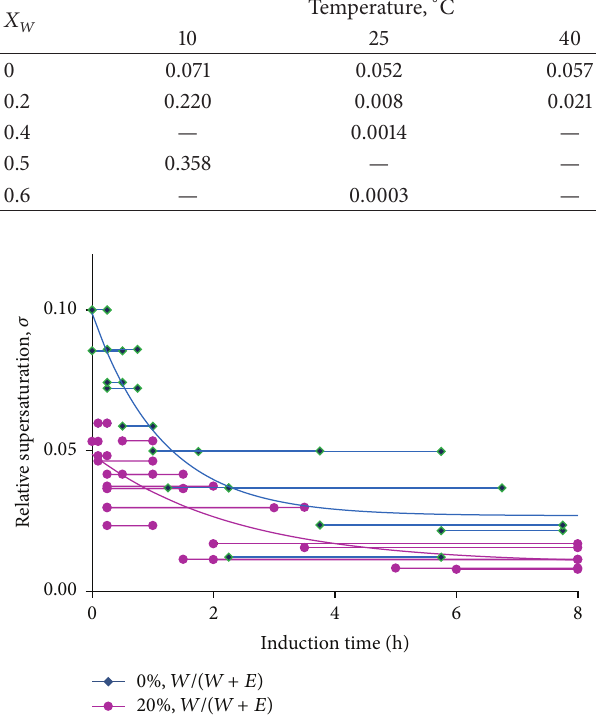
Figure 7: SNT in water-ethanol mixtures at 40 ∘ C for two different water concentrations. An exponential curve is drawn through the 20% data and compared with the previous curve for pure